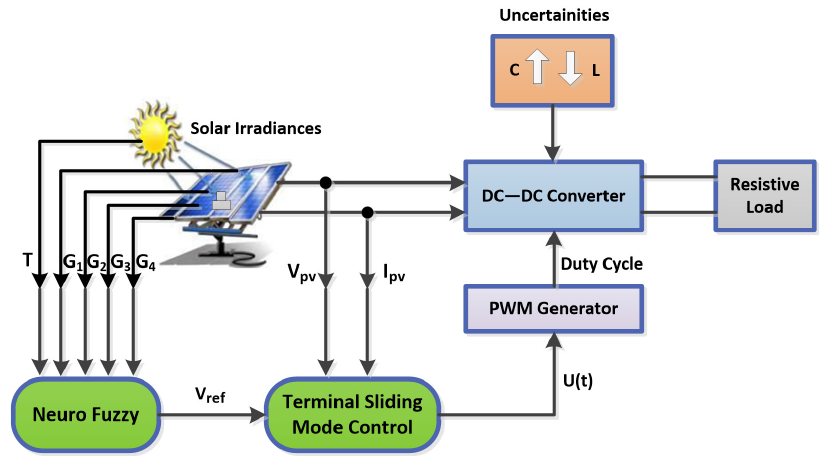
Figure 6. Proposed MLNF control scheme.